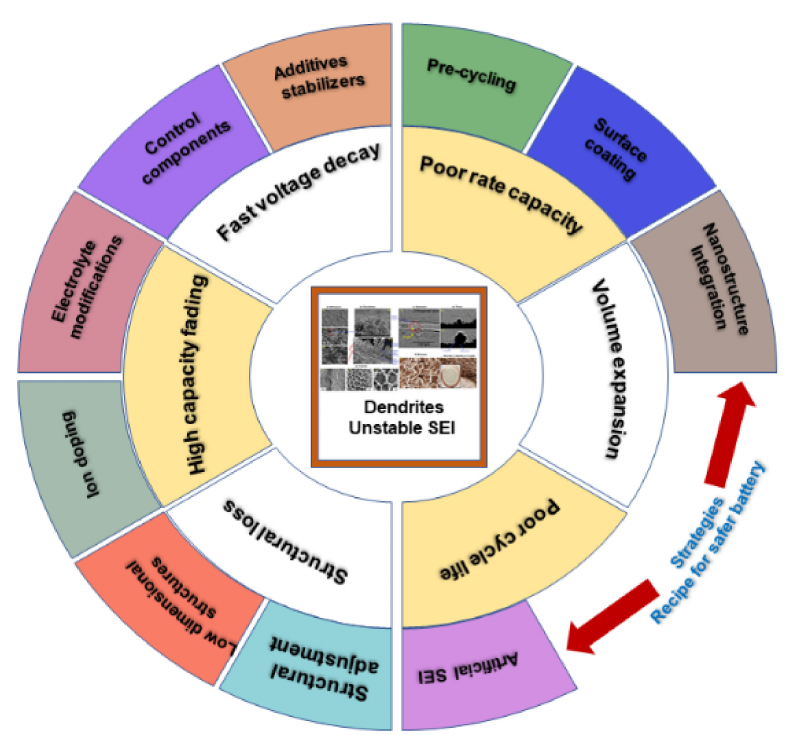
Figure 22. Challenges and strategies for dendrite elimination and growth